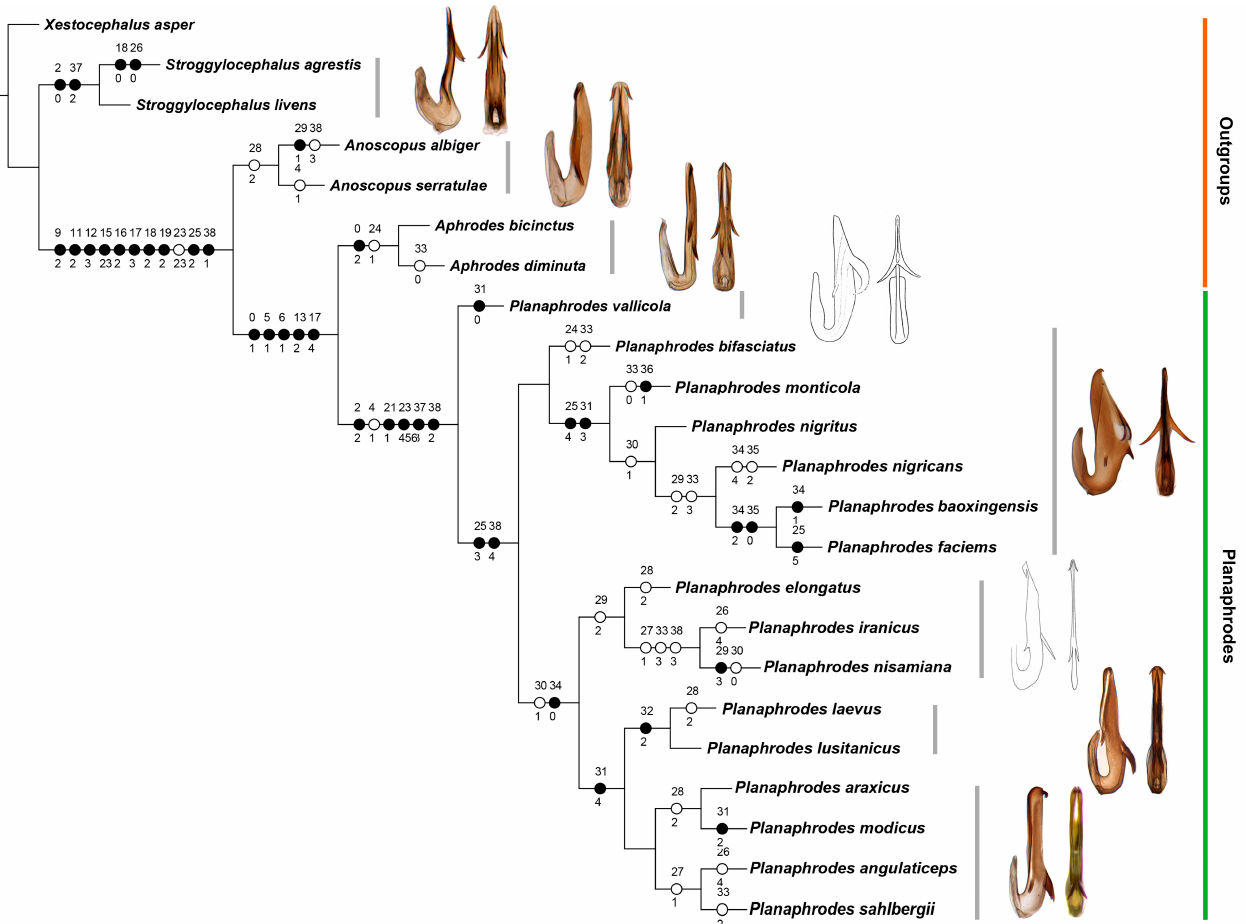
Figure 2. Phylogenetic hypothesis for the tribe Aphrodini from Figure 1 showing character state changes. Numbers above the circles refer to characters and those below refer to character state. Filled and open circles represent synapomorphies and homoplasious character changes, respectively. Lateral and ventral views of aedeagus from relative specimen have also been provided.